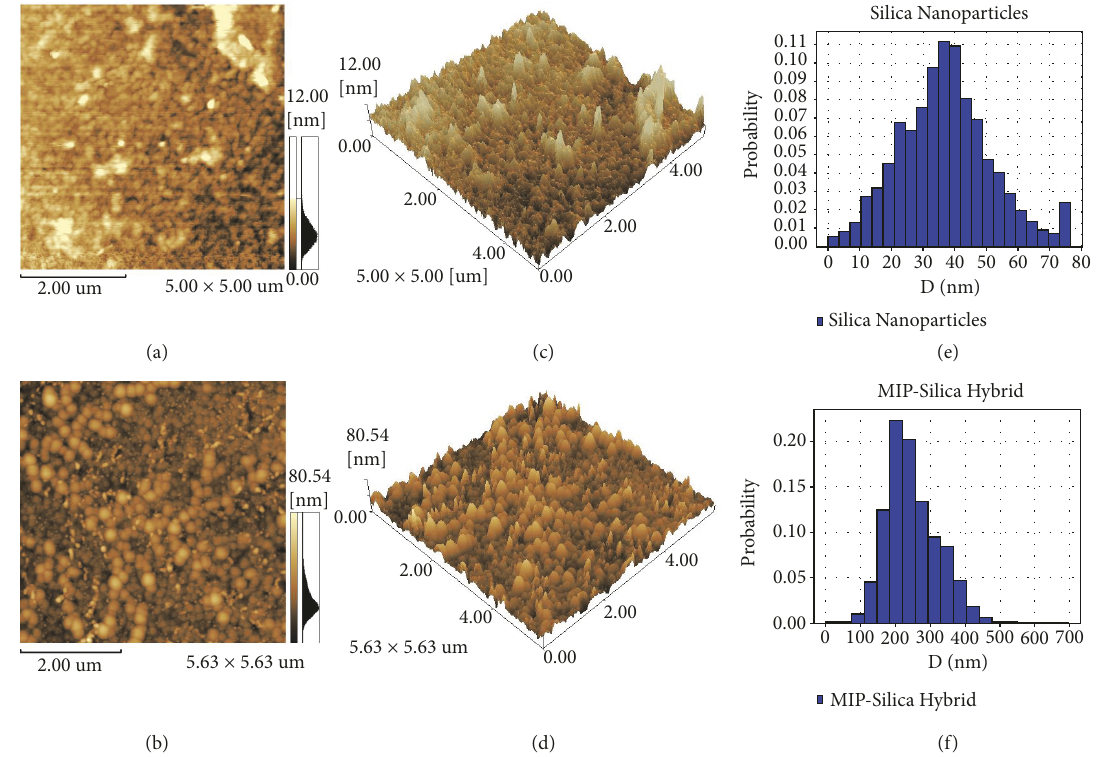
Figure 2: AFM micrographs of the as-prepared silica nanoparticles (a) and MIP-silica hybrid particles (b) showing nanoparticles distribution and surface morphology. The respective height scale 3-dimensional micrographs (c, d) and the histograms (e, f) of as-prepared silica nanoparticles and MIP-silica hybrid particles are also shown.